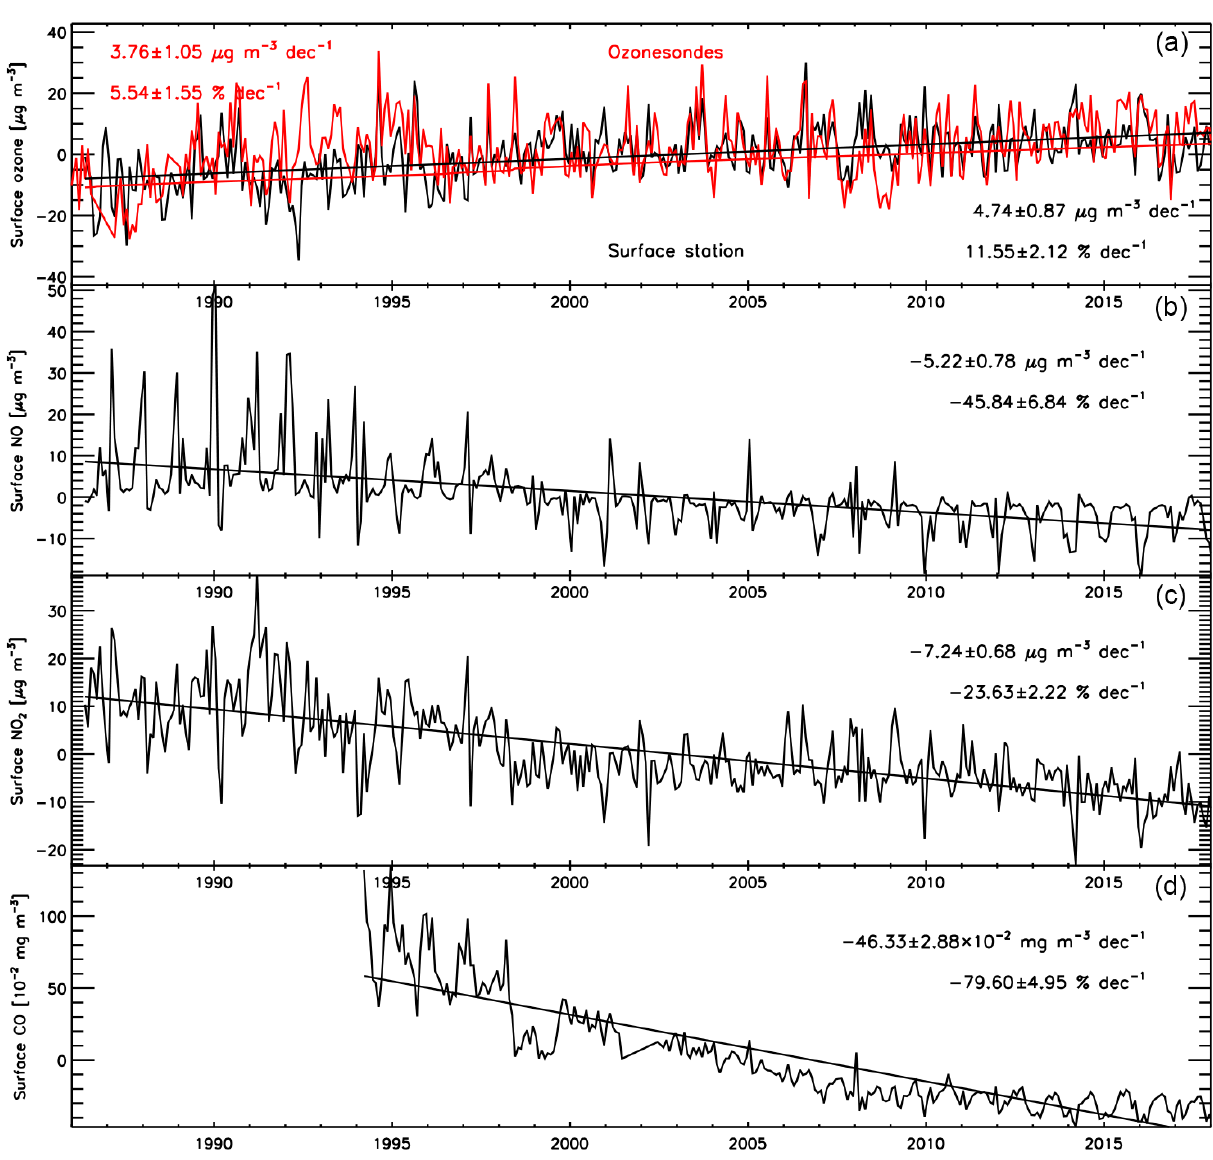
Figure B2. Monthly anomaly time series of Uccle surface ozone ( a , black) and mean ozone in the lowest 1km above Uccle from the ozonesonde launches ( a , red) and ozone precursor measurements at Uccle (NO, NO 2 ) and Elsene (CO, 5km from Uccle). Linear trends are shown along with the absolute and relative trend estimates and their 2 σ